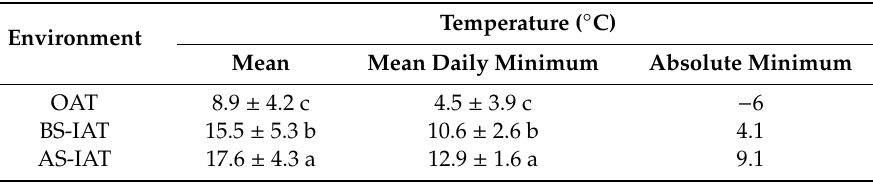
Table 4. Main measured temperature outside (OAT) and inside (IAT) the greenhouse. Data are expressed as average ± standard deviation. Means that do not share a letter are significantly different.